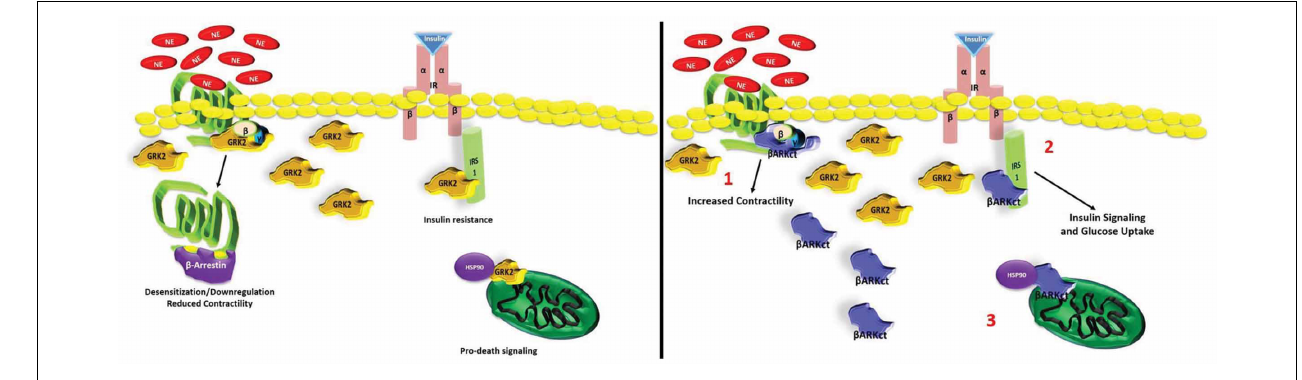
FIGURE 2 | Multiple protective role of β ARKct in failing myocardium against high GRK2 levels. Schematic representation of GRK2-inhibition mediated by β ARKct: (1) β ARKct, like GRK2, binds to G βγ subunits after GPCR (e.g., β ARs) activation and reduces the capability of GRK2 to induce dysregulation/downregulation of these